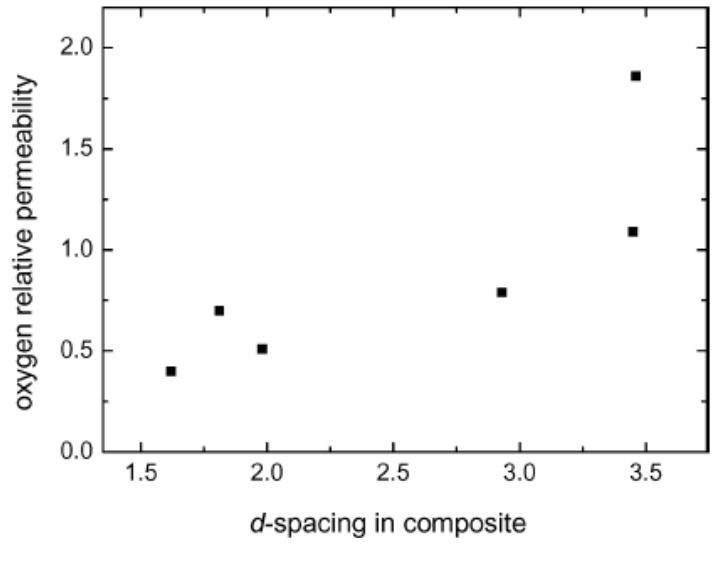
Figure 10. Correlation of the relative oxygen permeability through the nanocomposite films as a function of basal plane spacing of the filler in the composites. Reproduced from reference [45] with permission from The American Chemical